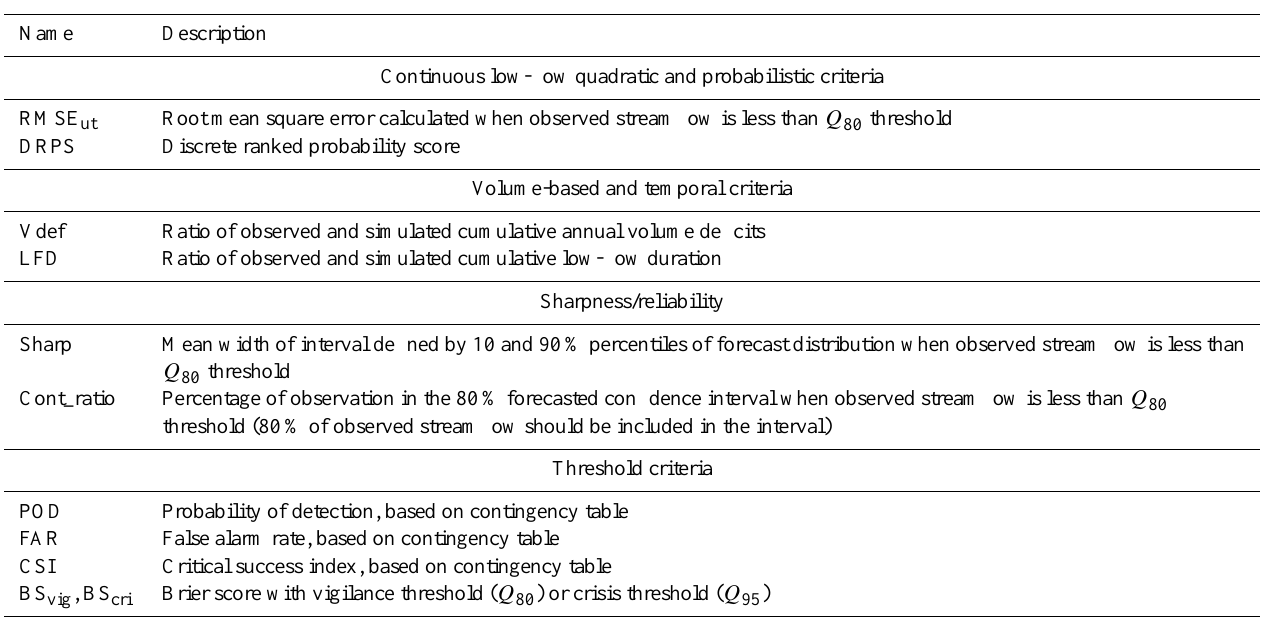
Table 5. List of efficiency criteria used for model evaluation in forecasting mode (see details in